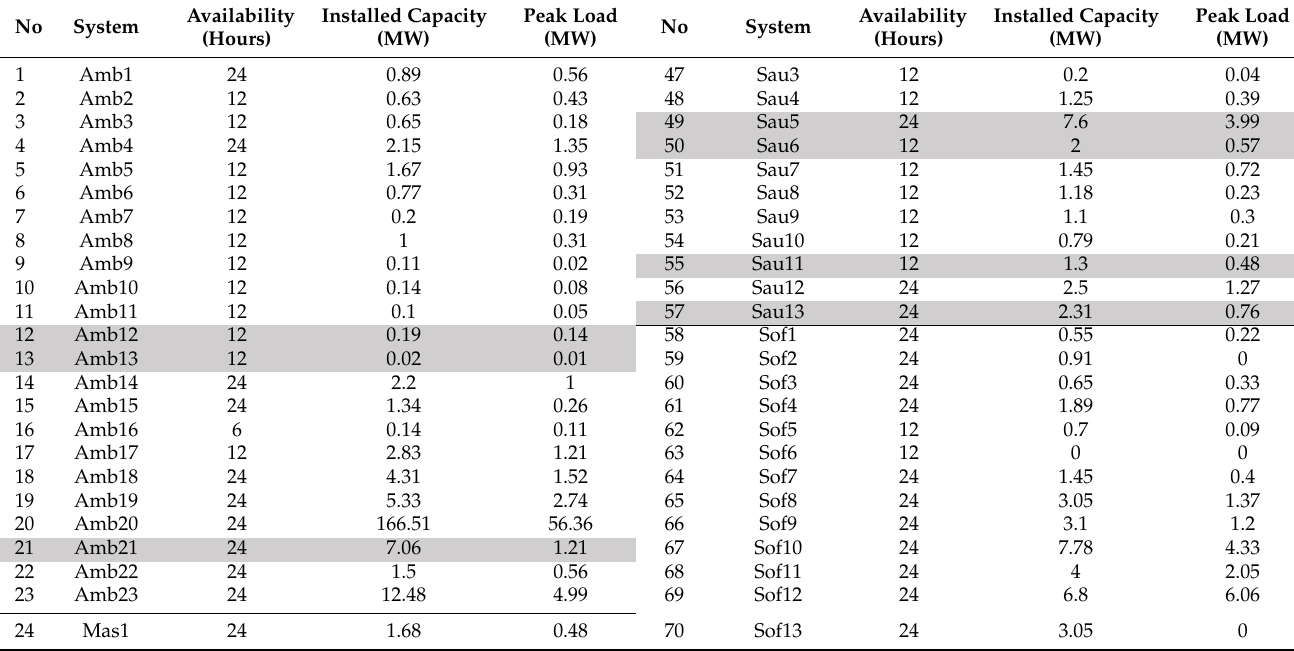
Table A3. Maluku and North Maluku system sizes in May 2021 (PLN data). The ones in grey are microgrids with PV (and battery)